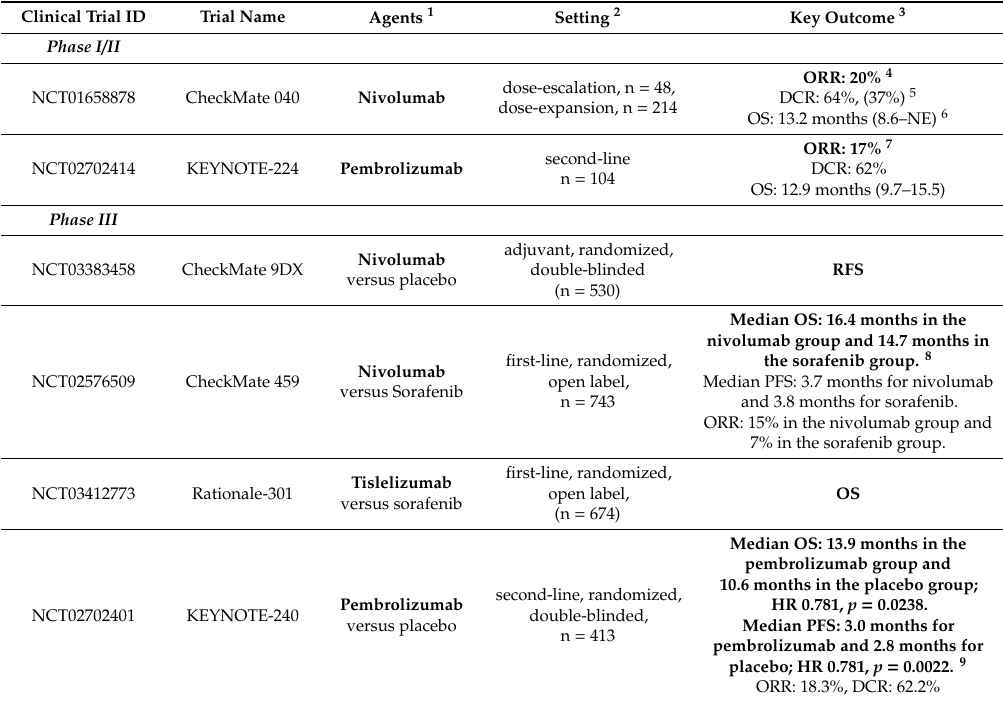
Table 1. Clinical trials and outcomes of immune checkpoint monotherapies in